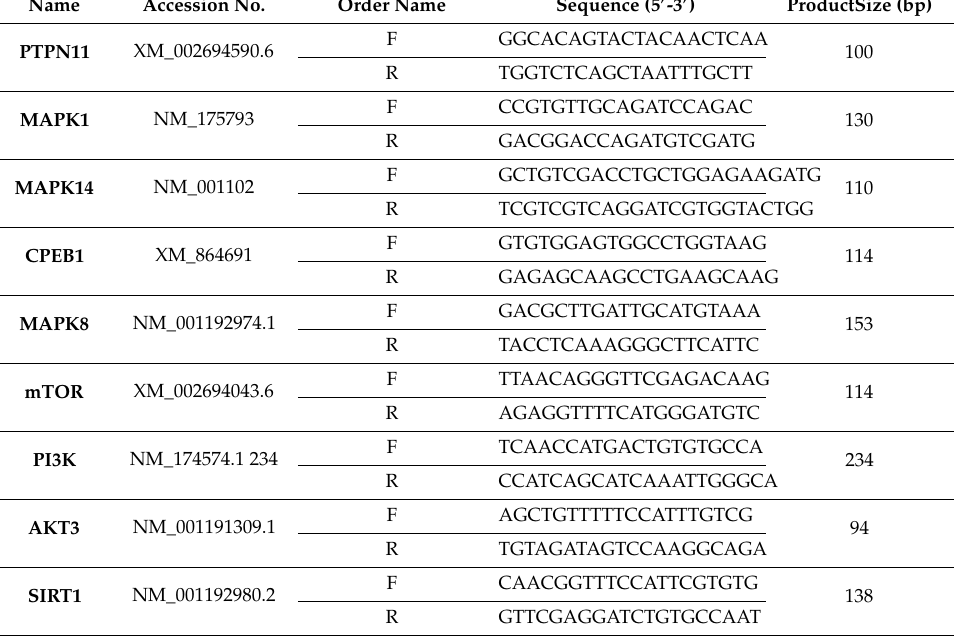
Table 1. Primers, their accession number, sequence and size used in